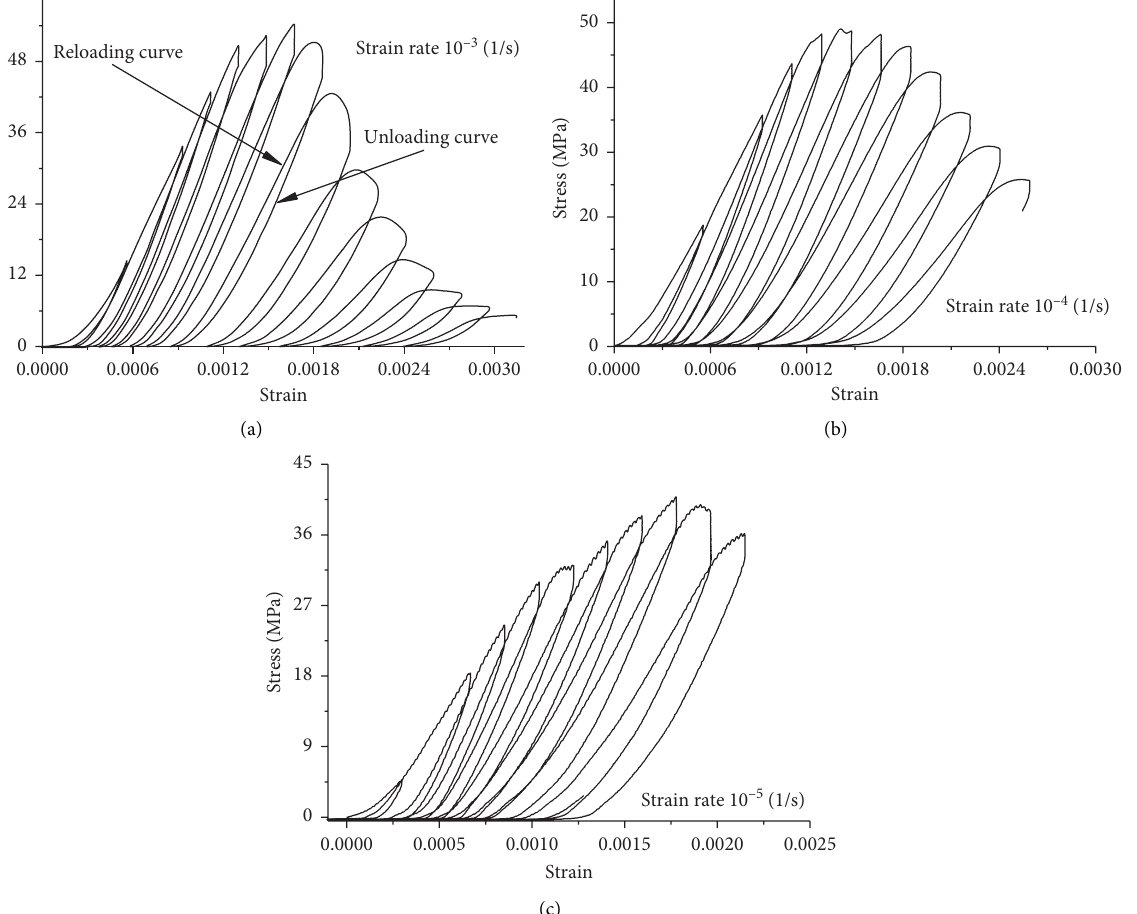
Figure 2: Stress-strain curves of concrete under cyclic compression loading with different strain rates: (a) strain rate of 10 − 3 s − 1 ; (b) strain rate of 10 − 4 s − 1 ; (c) strain rate of 10 − 5 s − 1